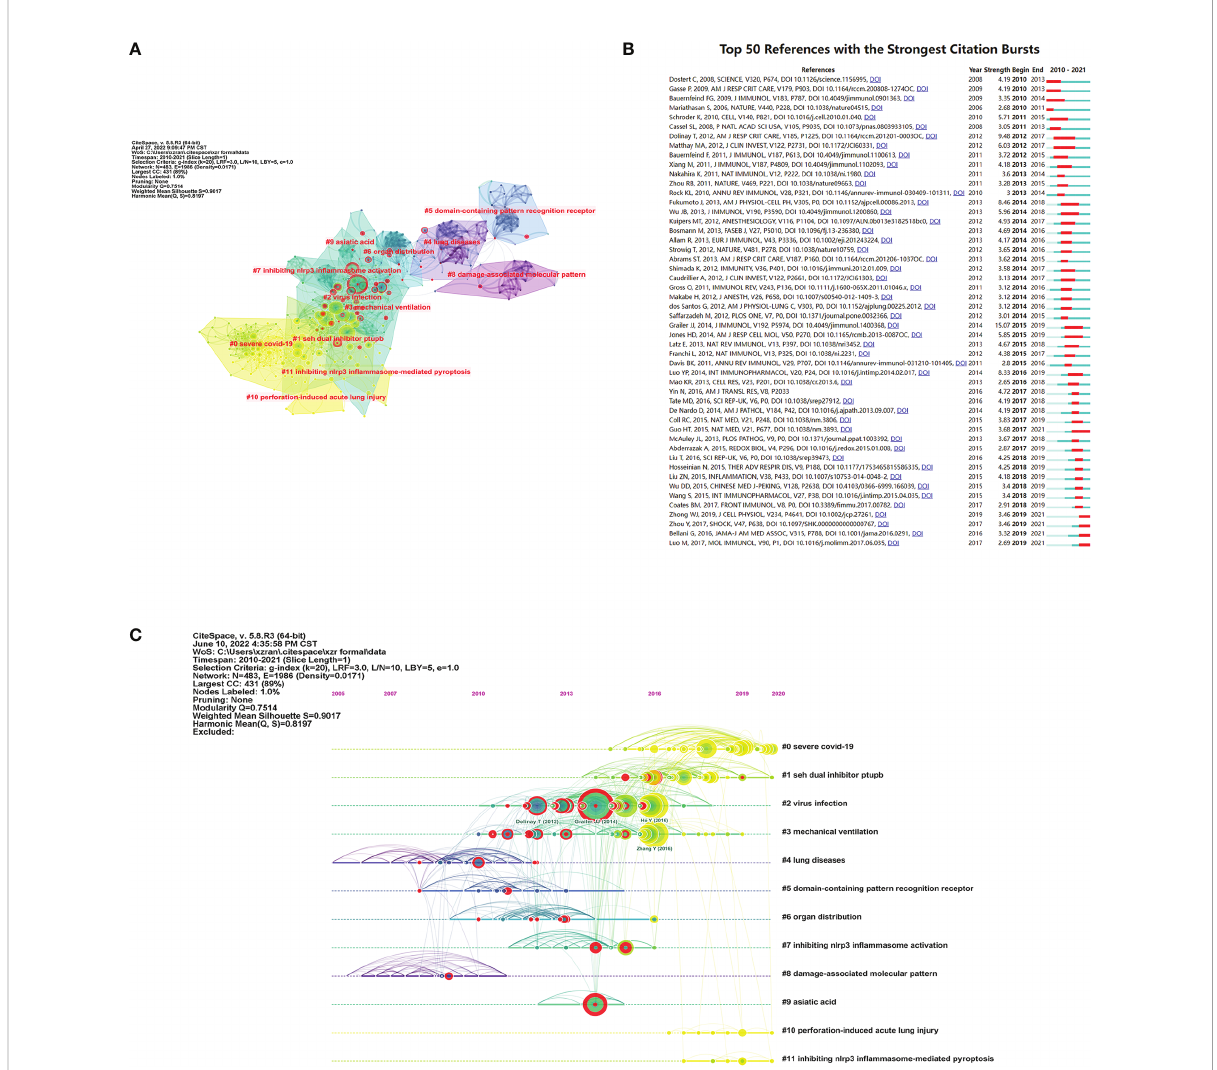
FIGURE 8 Burst detection and timeline view. (A) Burst references marked with red rings in the co-citation network. (B) Burst strength and time duration of the top 50 references with the strongest citation bursts. (C) Timeline view of the 12